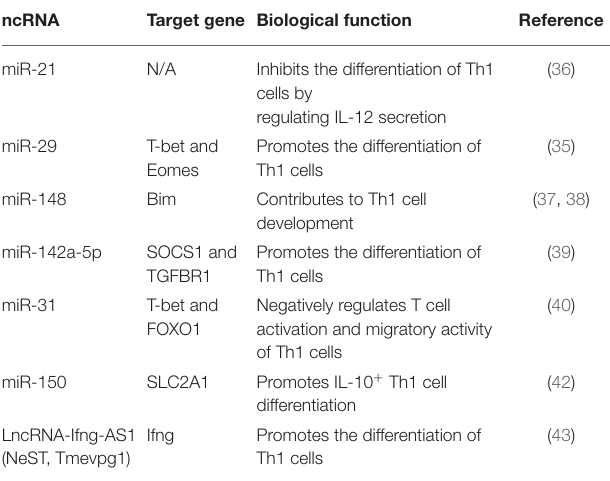
TABLE 2 | ncRNAs involved in Th1